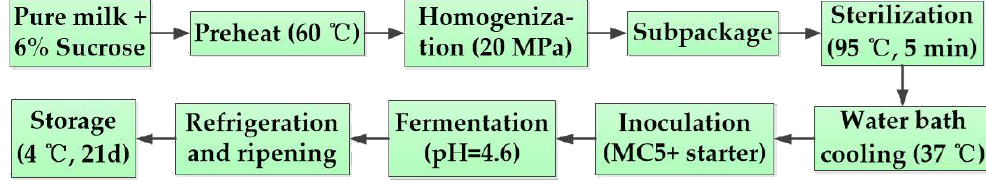
Figure 1. The production process of yogurt. Table 2. Inoculated amount of MC5 and starters in four groups of yogurt samples. Types of Yogurt